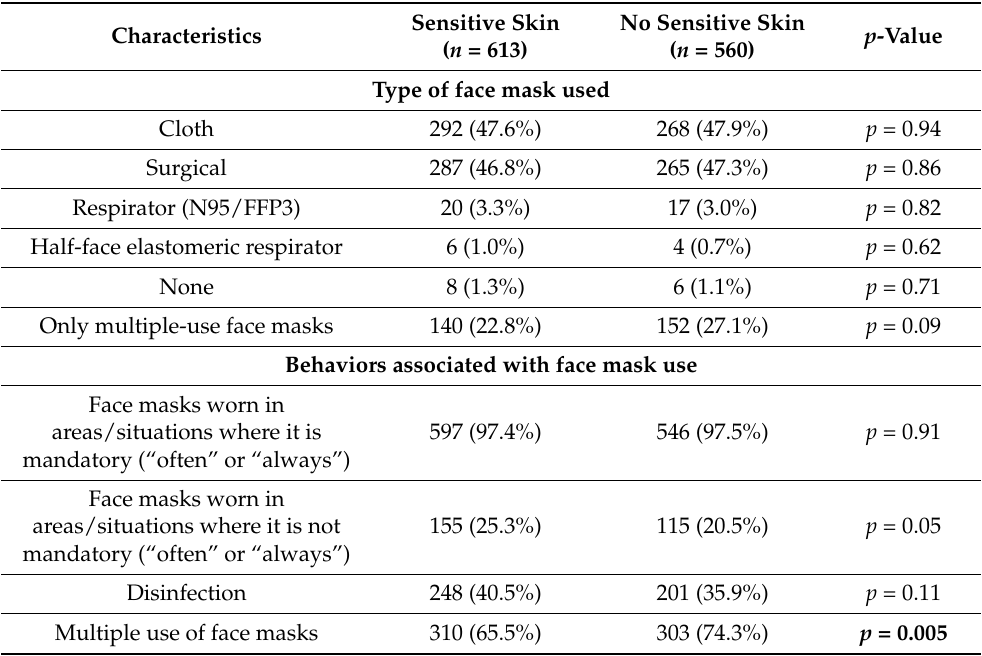
Table 3. The influence of sensitive skin on the type of face mask used and other face mask-related behaviors. The values in bold are considered statistically significant.